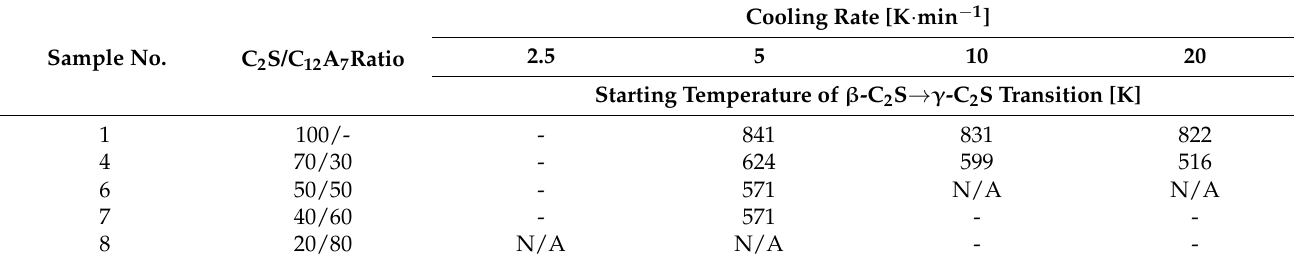
Table 6. Temperature at which the transition from β -C 2 S to γ -C 2 S started for different cooling rates (N/A—not applicable, polymorphic transition did not occur).